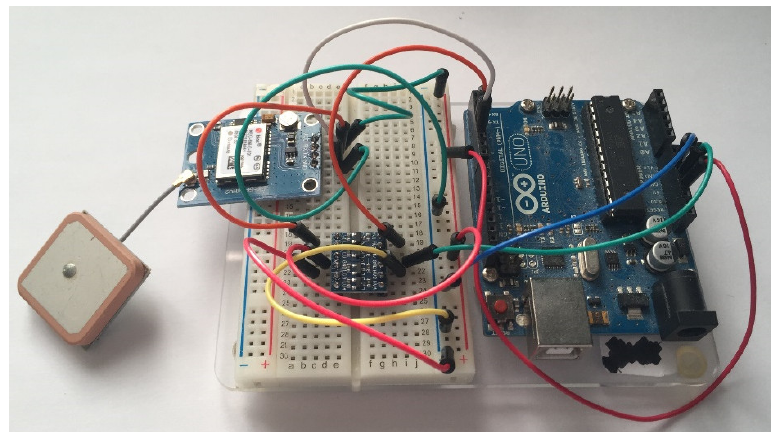
Figure 14. Photo showing the Arduino Uno GPS module testing Arduino Uno. Sensors 2019 , 19 , 347